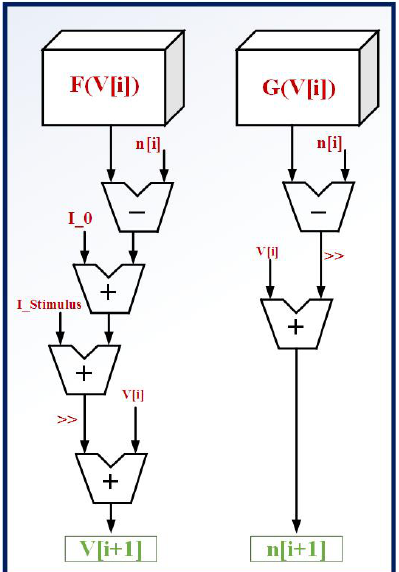
Figure 9. Scheduling diagrams for realizing the basic variables, V and n